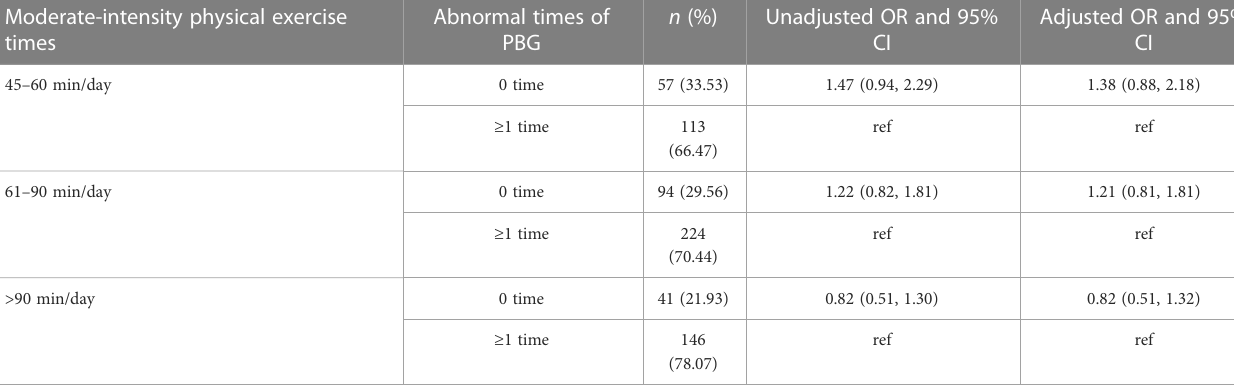
TABLE 5 The association between daily physical exercise duration and times of abnormal PBG in women with GDM. Moderate-intensity physical exercise times